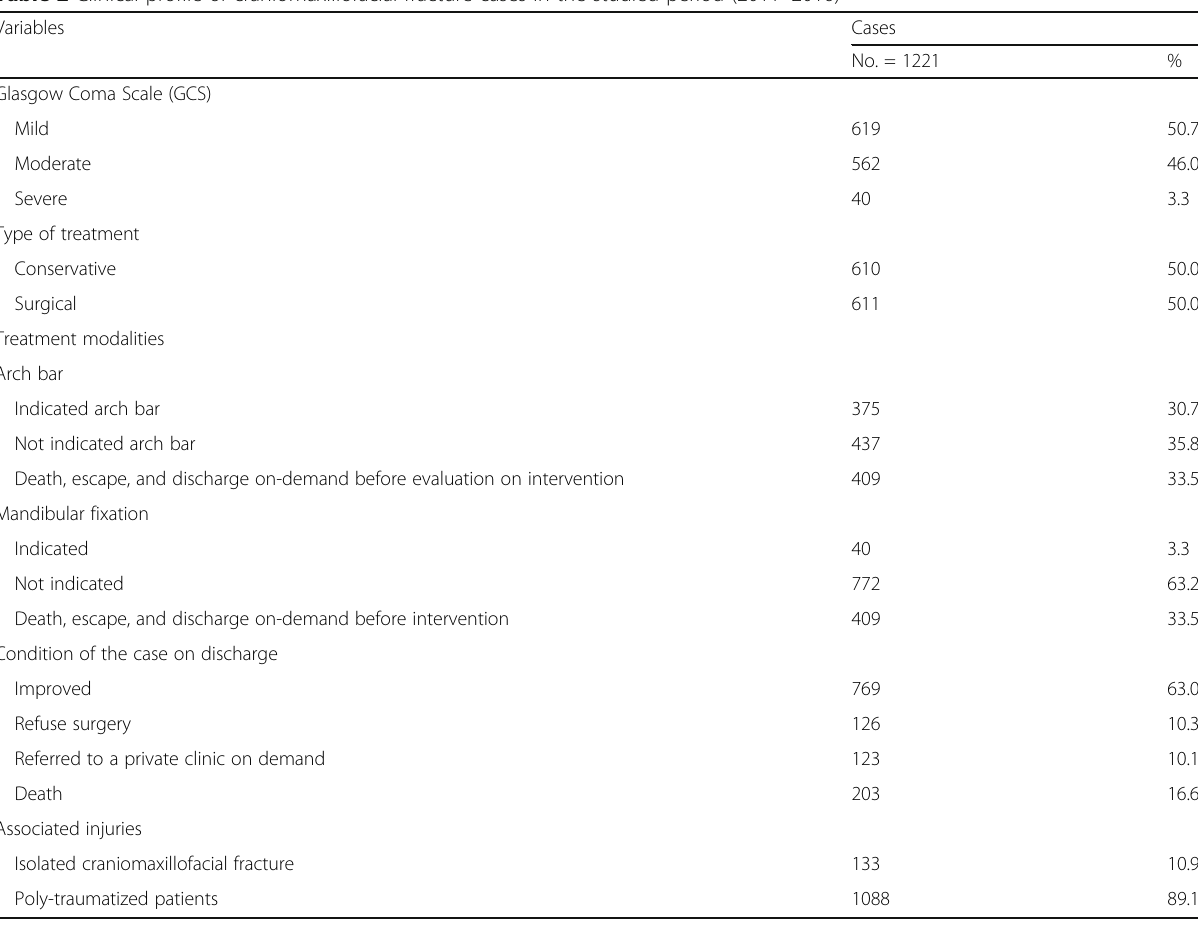
Table 2 Clinical profile of craniomaxillofacial fracture cases in the studied period (2011 –